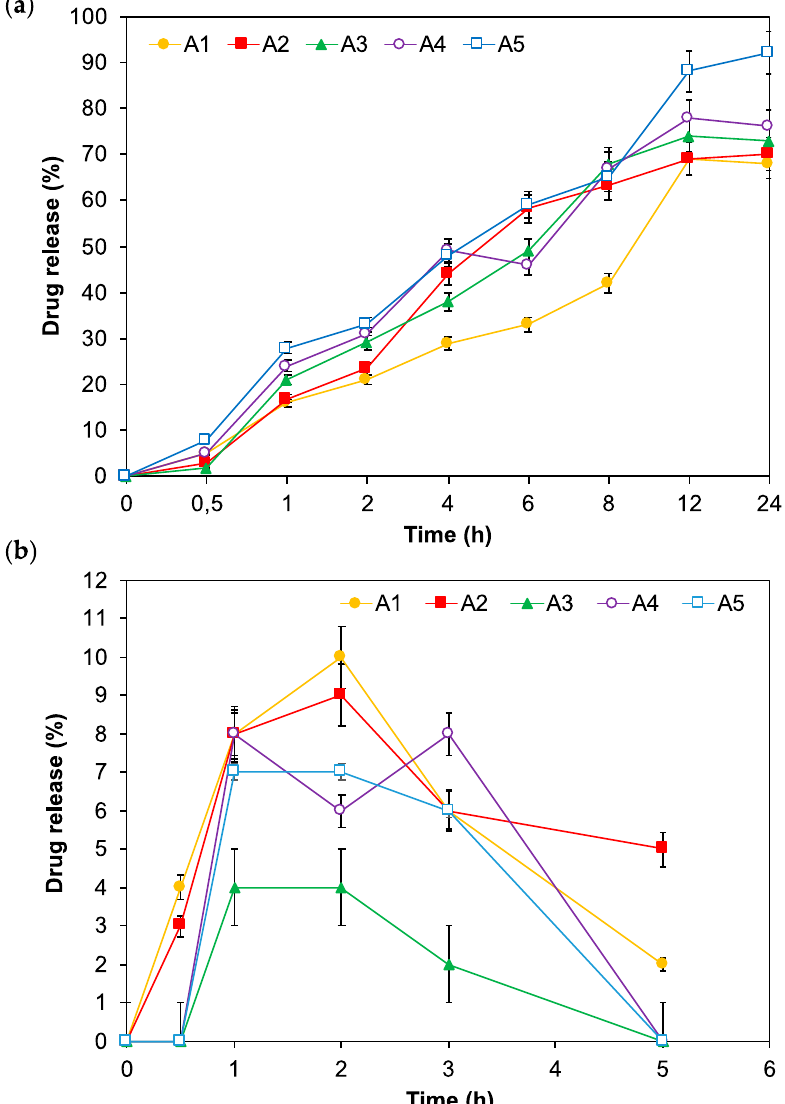
Figure 3. Insulin release profiles at pH 7.4 ( a ) and at pH 1.2 ( b ). Formulations A1–A5: A1